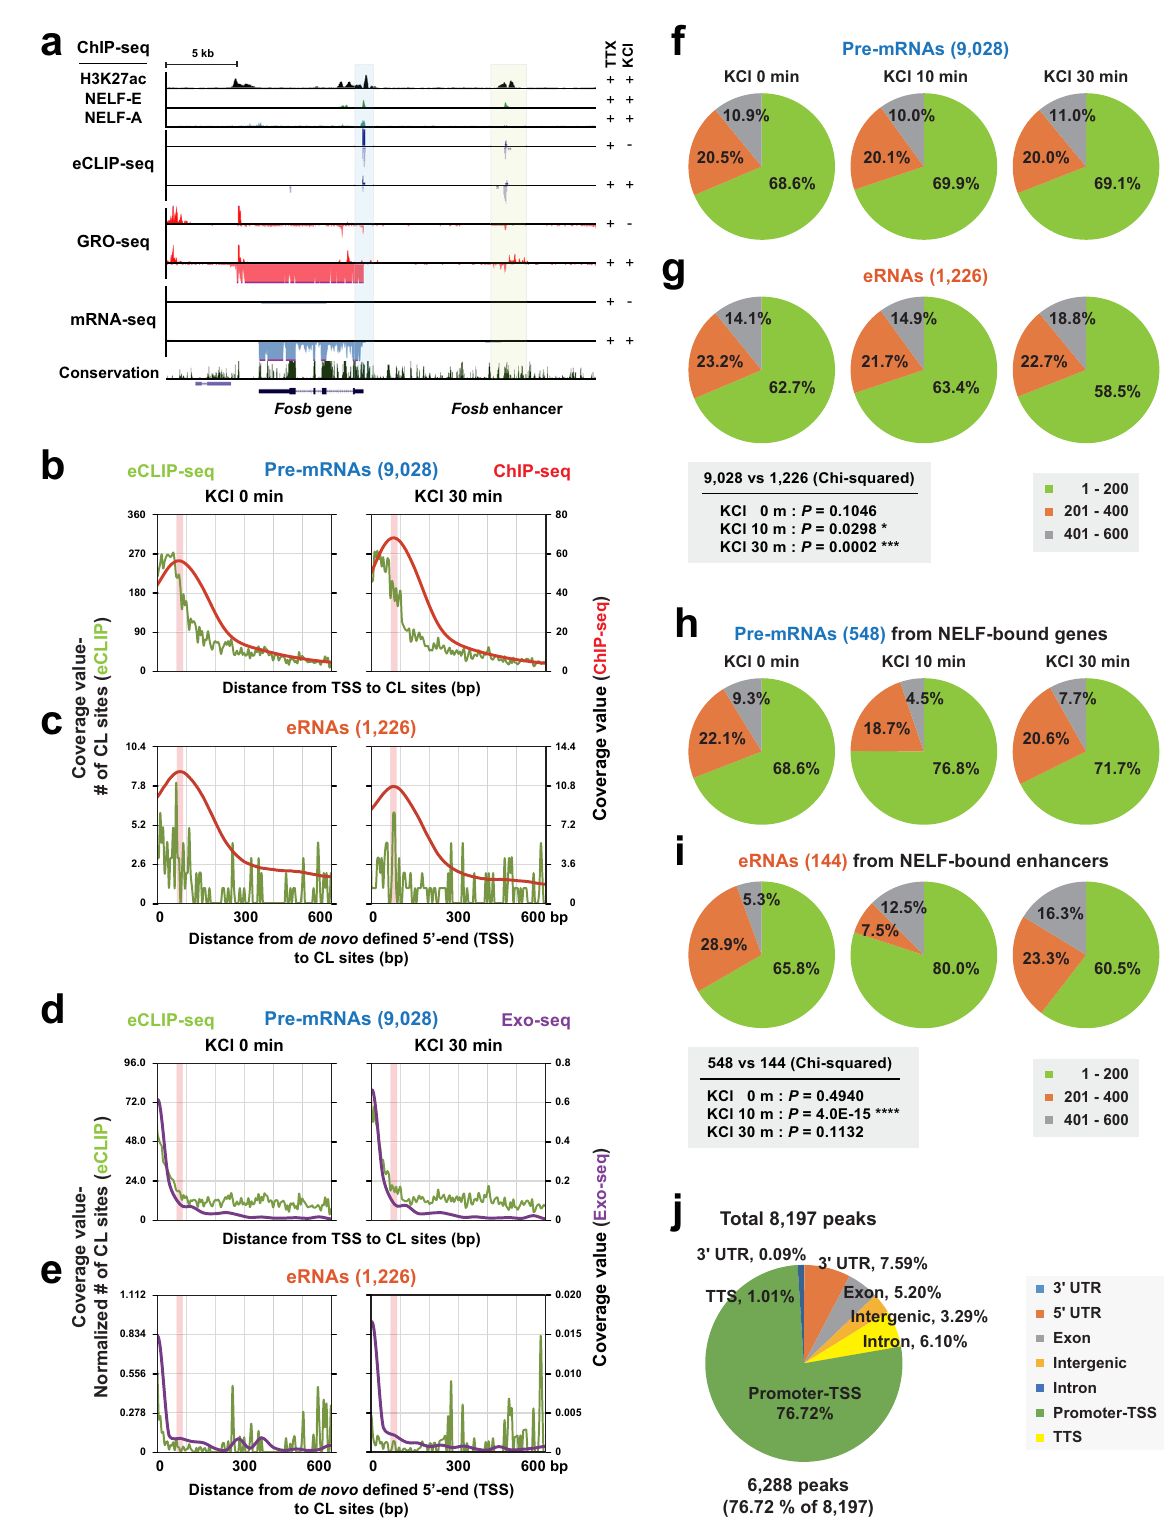
(Fig. 5c, g and Supplementary Fig. 8b, d). To further examine 5 ′ -ends of nascent RNAs emerging from transcribing Pol II 32,46 (Fig. 5b, f and Supplementary Fig. 8a, c). About 70% of the whether or not the distribution of the crosslinking sites is in fl u- crosslinking sites were located within the fi rst 200 nt of nascent enced by the different abundance of individual nascent tran- pre-mRNAs in both unstimulated (Unst.; 0 min) and KCl- scripts, we normalized the crosslinking numbers by GRO-seq stimulated conditions with a notable enrichment in the fi rst 50 signals. The proportion of the crosslinking sites near the 5 ′ -end of nt. The distribution of the crosslinking sites within eRNAs was eRNAs became much lower after normalization, resulting in more similar but more broadly spread toward downstream regions evenly distributed crosslinking events across the length of eRNAs. NATURE COMMUNICATIONS| (2022) 13:2429